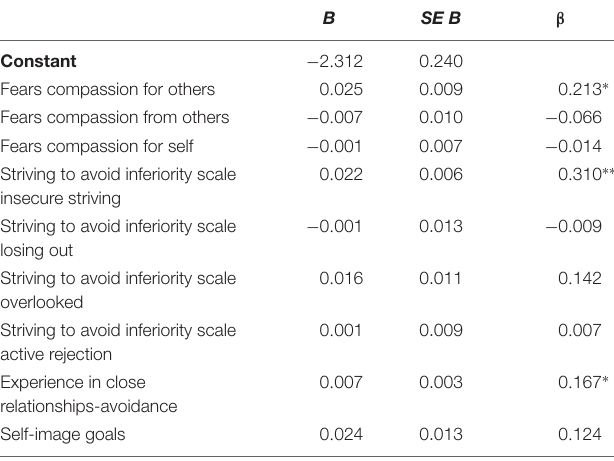
TABLE 5 | Multiple linear regression with antisocial leadership as the dependent variable and fears compassion for others, from others, and for self, insecure striving, fears of losing out overlooked, active rejection, avoidance in close relationships, and self-image goals as independent variables. B SE B